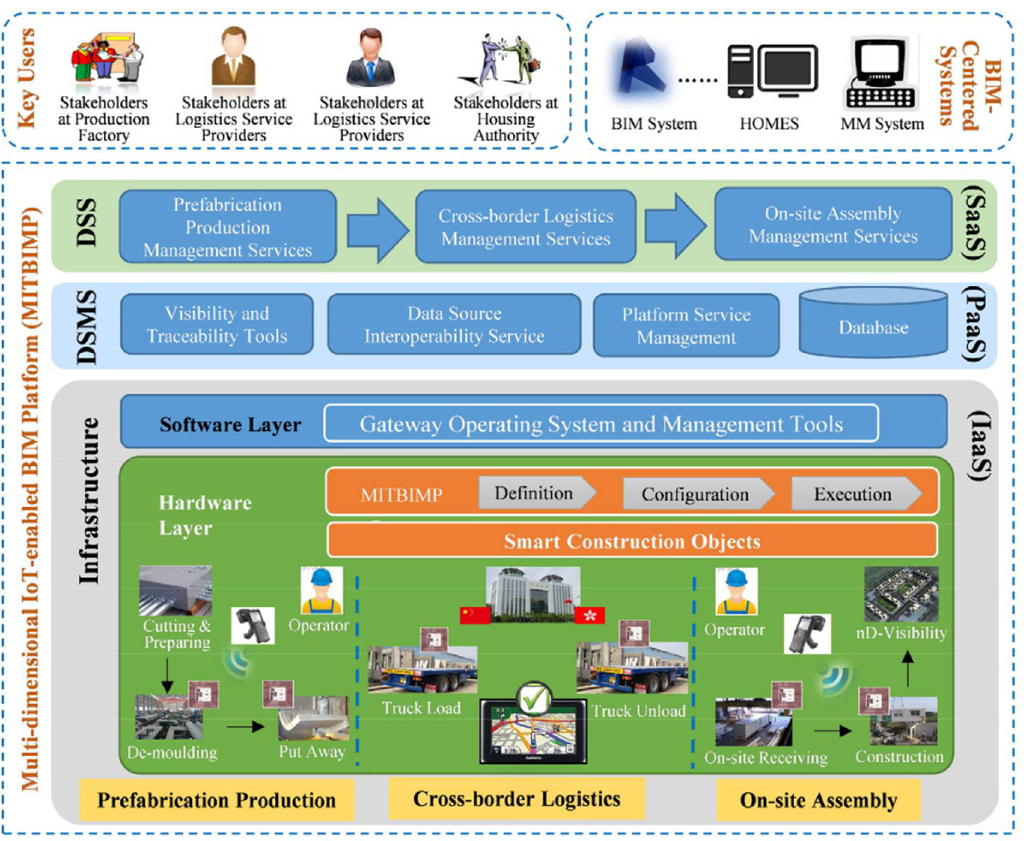
Figure 3. Offsite construction value chain. Reprinted with permission from Reference [35]. Copy- right 2017 Copyright Elsevier B.V.